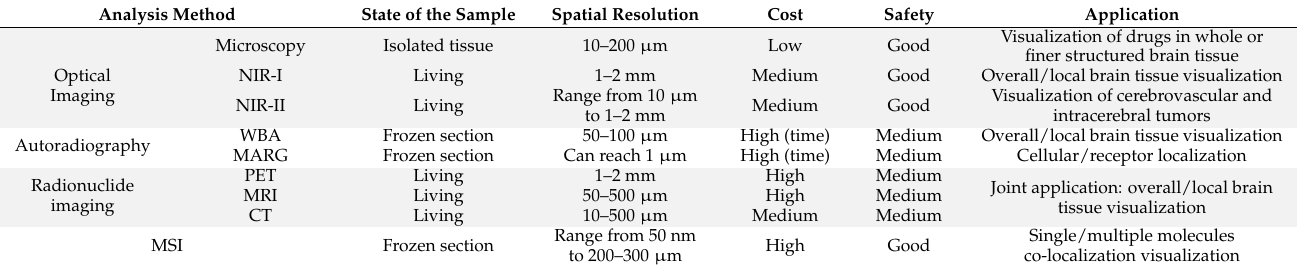
Table 1. Comparison of imaging techniques for the assessment of cerebral